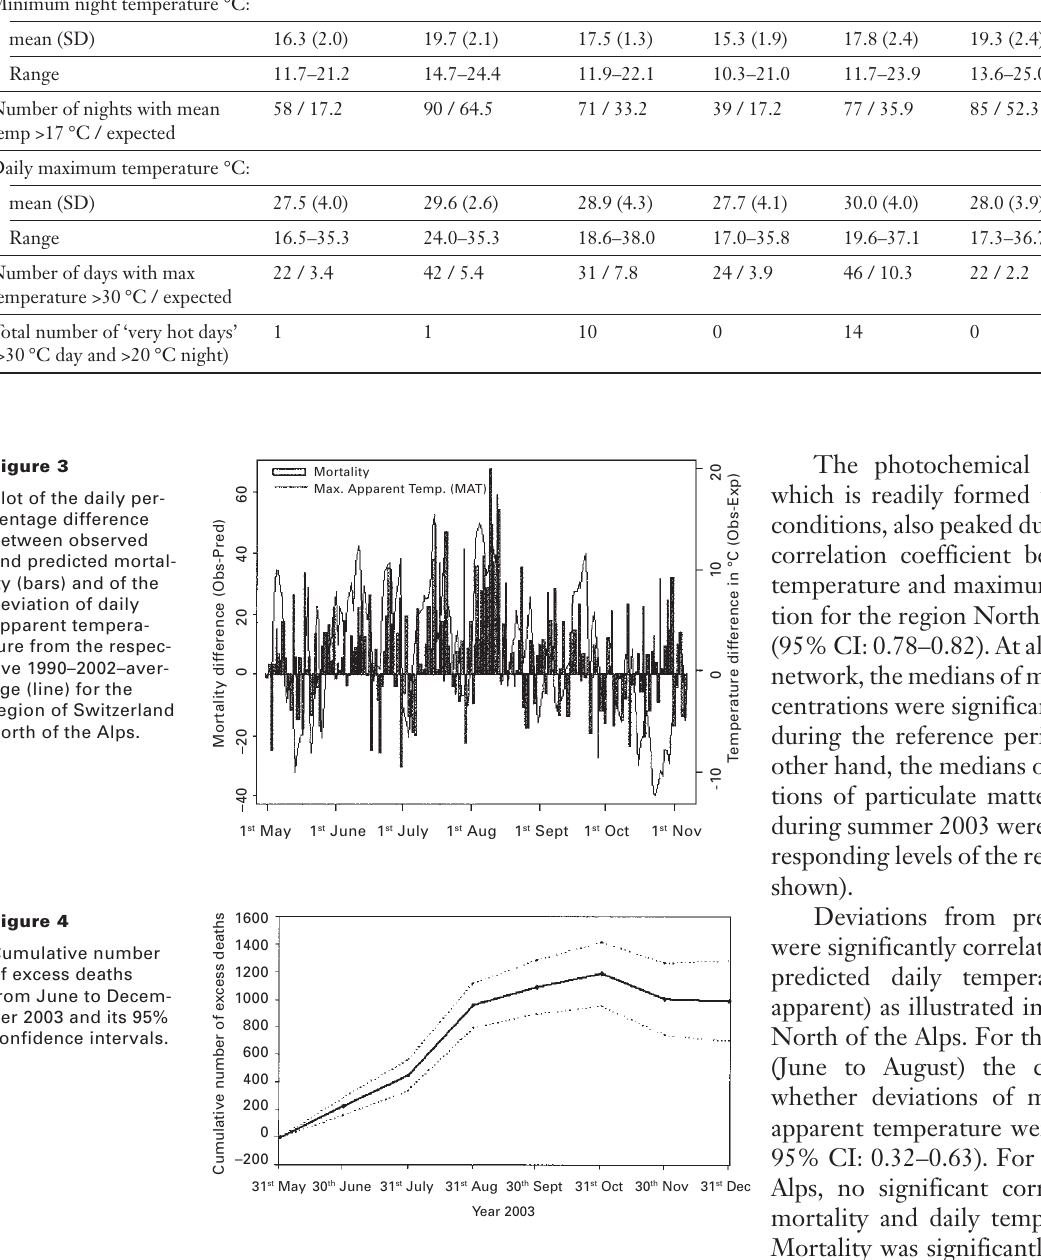
Meteorological and air pollution characterisation during summer 2003 (June to August).